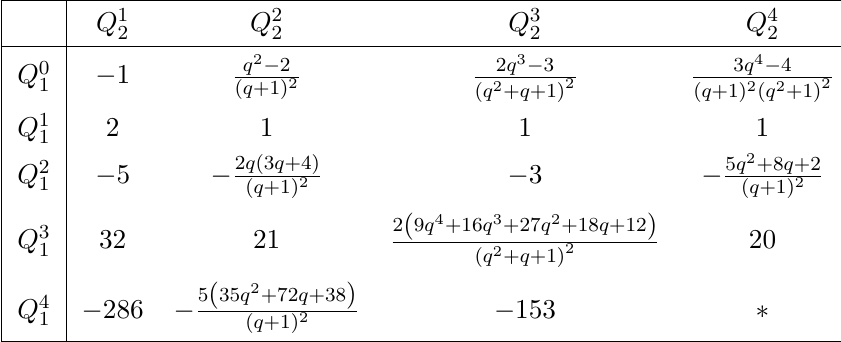
can be chosen to have classical pieces F (cid:13) ; in this basis F 3 ; 4 with (cid:11) = (cid:0) 1 are listed in table 4 4 12